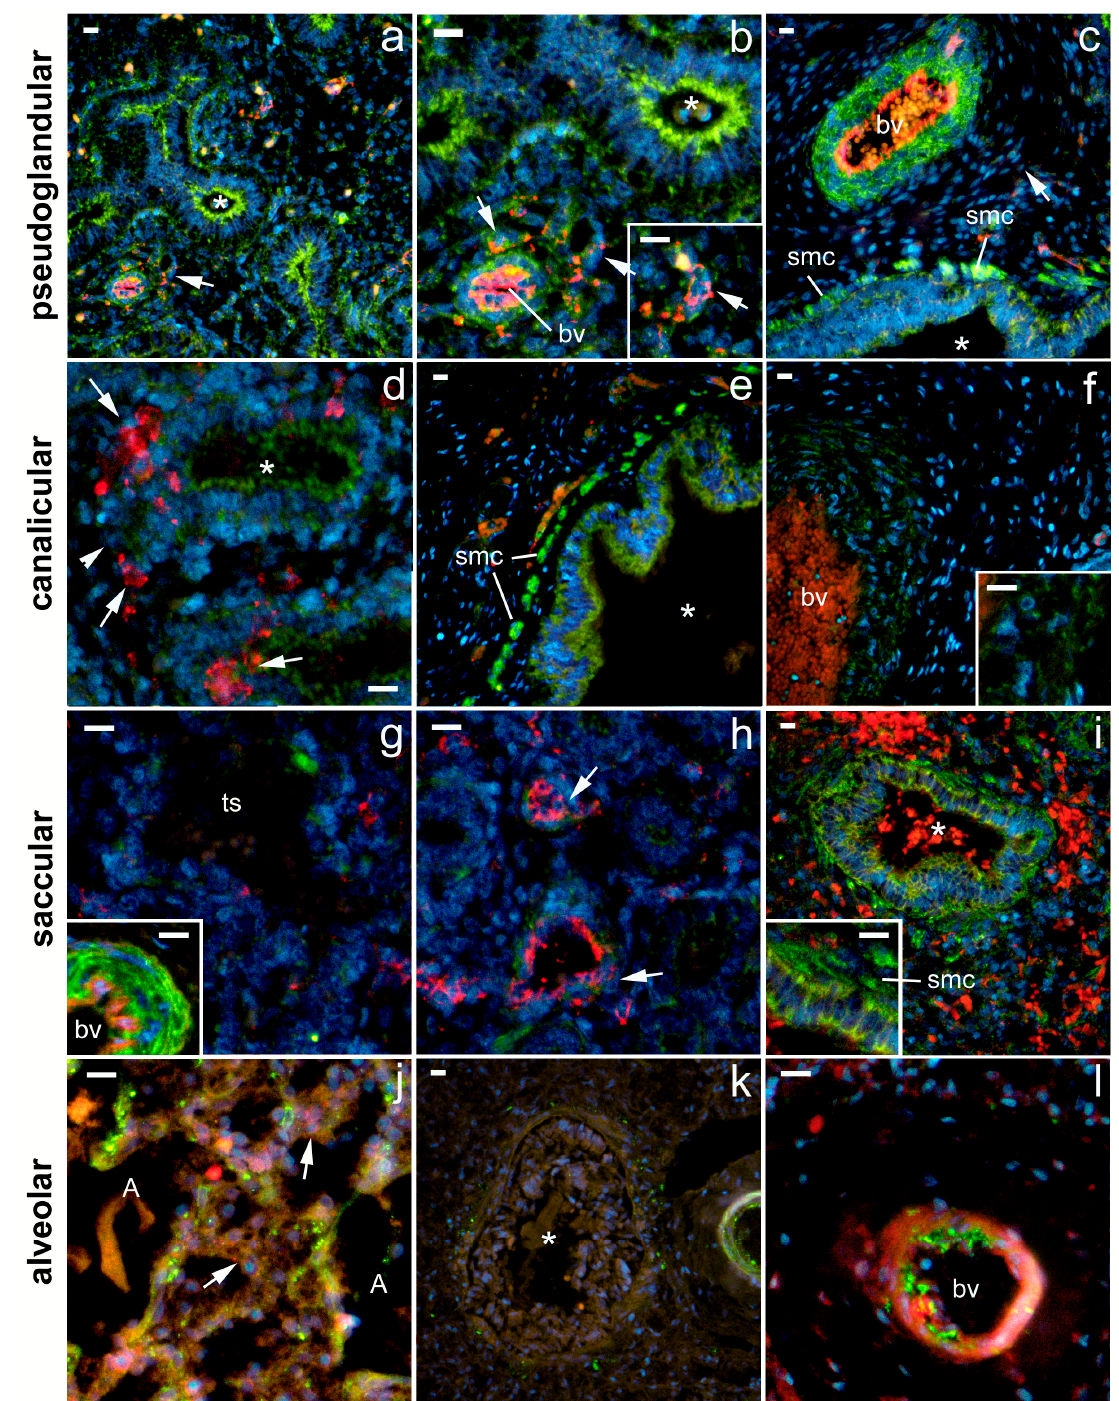
Figure 2. Immunofluorescence staining of fetal human lungs at different developmental stages: pseudoglandular ( a – c ), canalicular ( d – f ), saccular ( g – i ), and alveolar ( j – l ) with 5-HT1A and CD31/PECAM markers. Nuclear staining DNA DAPI is shown in parallel with 5-HT1A and CD31/PECAM im- munofluorescence (merge). Green staining—positive 5-HT1A receptor expression, red staining— CD31/PECAM-1 expression, and blue staining—nuclei stained with 6-diamidino-2-phenylindole di- hydrochloride (DAPI). Images were taken at 400 × magnification; ( a , c , e , f , i , k ) downsized images. Scale bar = 20 µ m. Asterisks—proximal airways/bronchioles; arrows—blood capillaries; arrowheads— distal airway bronchioles, cuboidal epithelium lining the air spaces; bv—blood vessel (mostly artery); smc—smooth muscle cells; ts—terminal sacs;